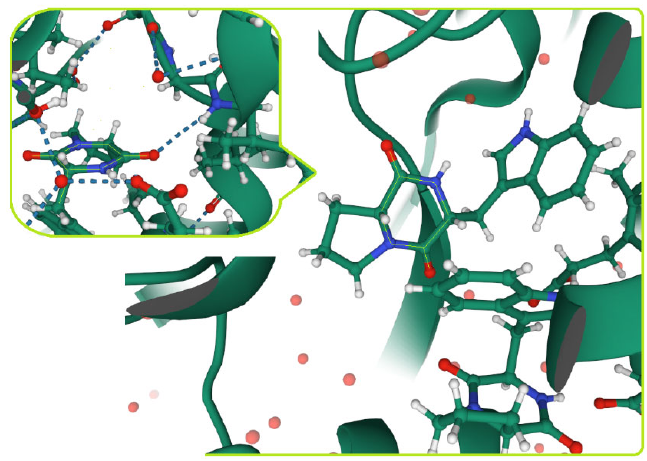
Figure 2. Crystal structure of cytochrome P450 NasF5053 Q65I-A86G mutant variant from Figure 2 . Crystal structure of cytochrome P450 NasF5053 Q65I ‐ A86G mutant variant from Streptomyces sp. NRRL F ‐ 5053 in the cyclo( L ‐ Trp ‐ L ‐ Pro) ‐ bound state; RCSB PDB ref. code: 6VZA.pdb Streptomyces sp. NRRL F-5053 in the cyclo( L -Trp- L -Pro)-bound state; RCSB PDB ref. [234]. On the left: The molecular view of supramolecular interactions, showing, e.g., synthon formed by (DKP) C = O H ‐ N H ‐ bonding interaction.